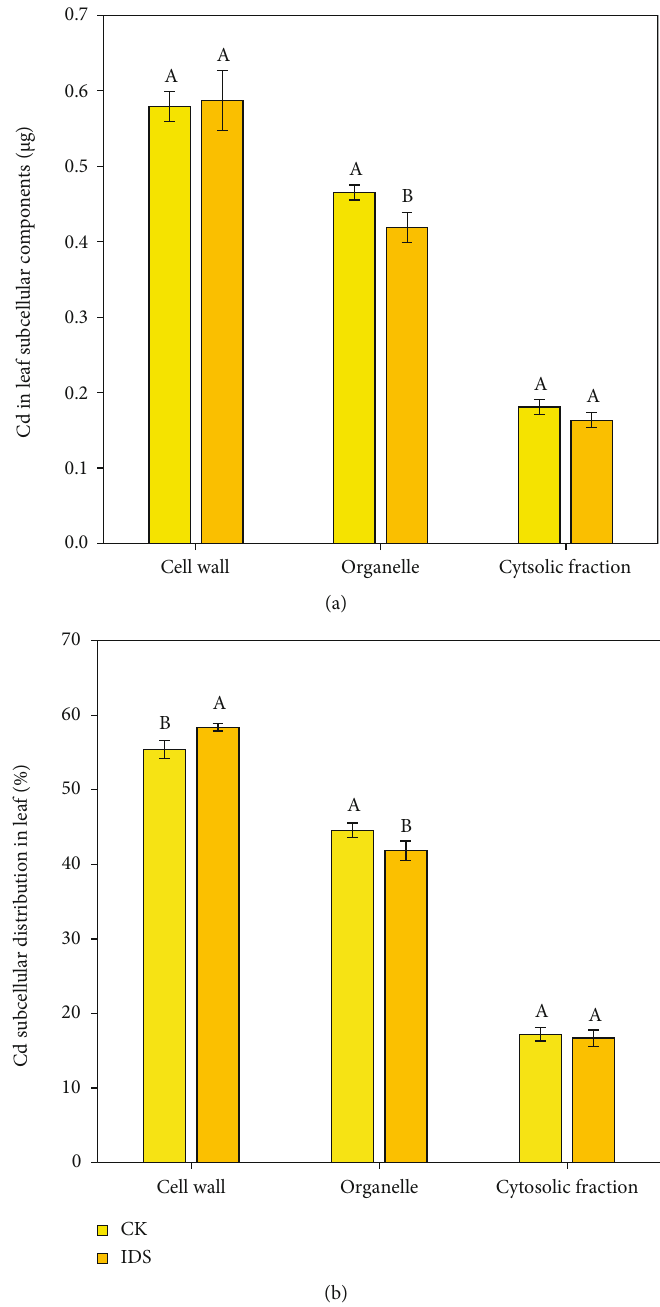
Figure 3: The e ff ects of IDS on the subcellular distribution ratio of Cd in rapeseed leaves. Mean ± SD ( n = 5 ). Di ff erent uppercase letters (A, B) indicate signi fi cant di ff erence between CK and IDS treatment at P < 0 : 05